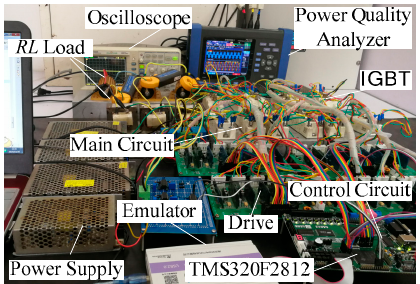
Figure 5. Experimental system.